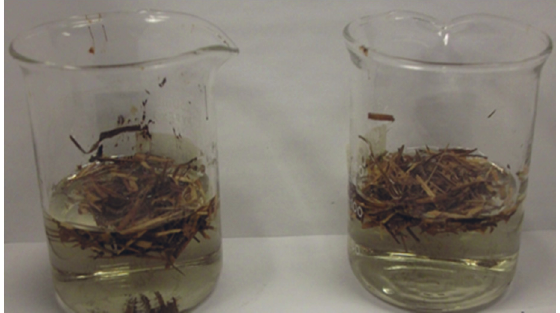
Figure 6. Bitumen samples with charred hay (60 min) added in deionized water ( left ) and Instant Ocean solution ( right ) at room temperature (23 °C) and time = 0 h.